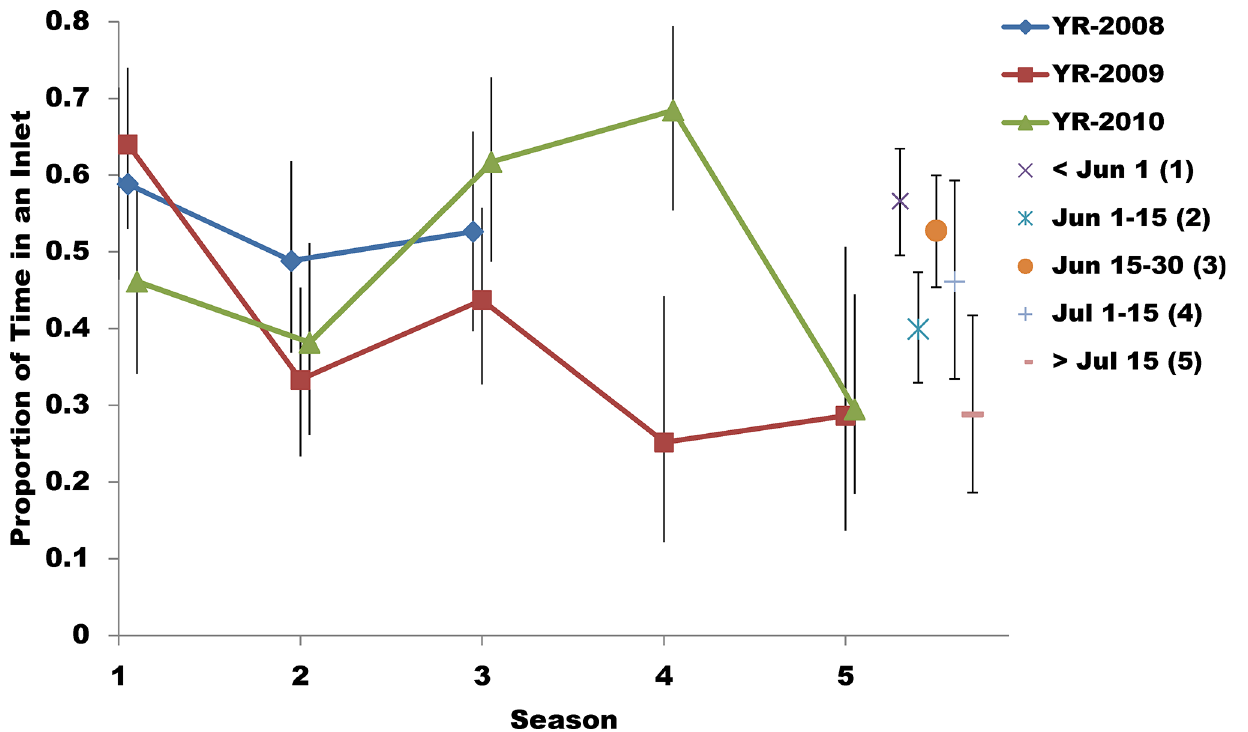
Fig 6. Proportion of time that radio-tagged harbor seals spent in glacial habitat. Proportion of time seals (n = 104; tagged in Endicott Arm) spent in Tracy or Endicott Arms by year and season. Vertical bars are 95% Confidence Intervals, by year, season, and location (on left), and (on right) by season (all years combined). Season numbers and their respective range of dates are in the